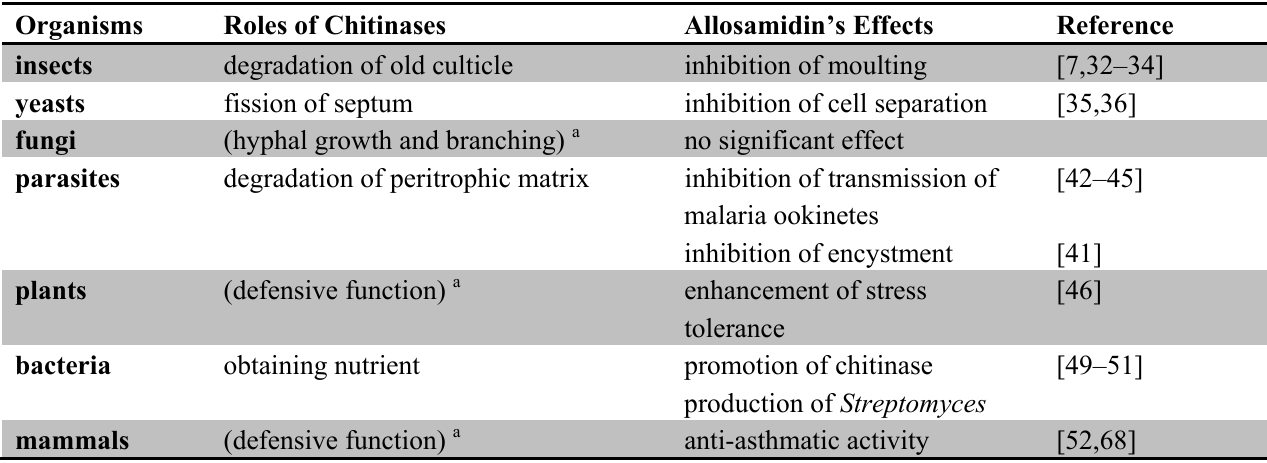
Table 1. Roles of chitinases and allosamidin’s